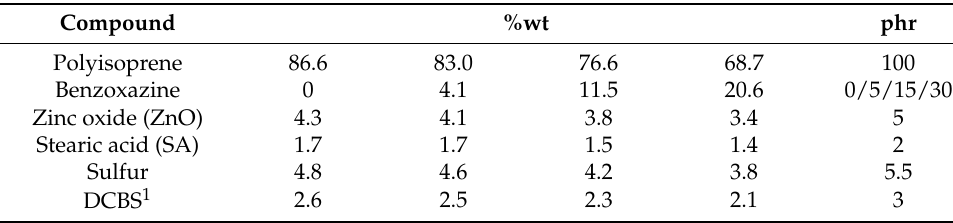
Table 1. Model formulation containing polyisoprene used in this